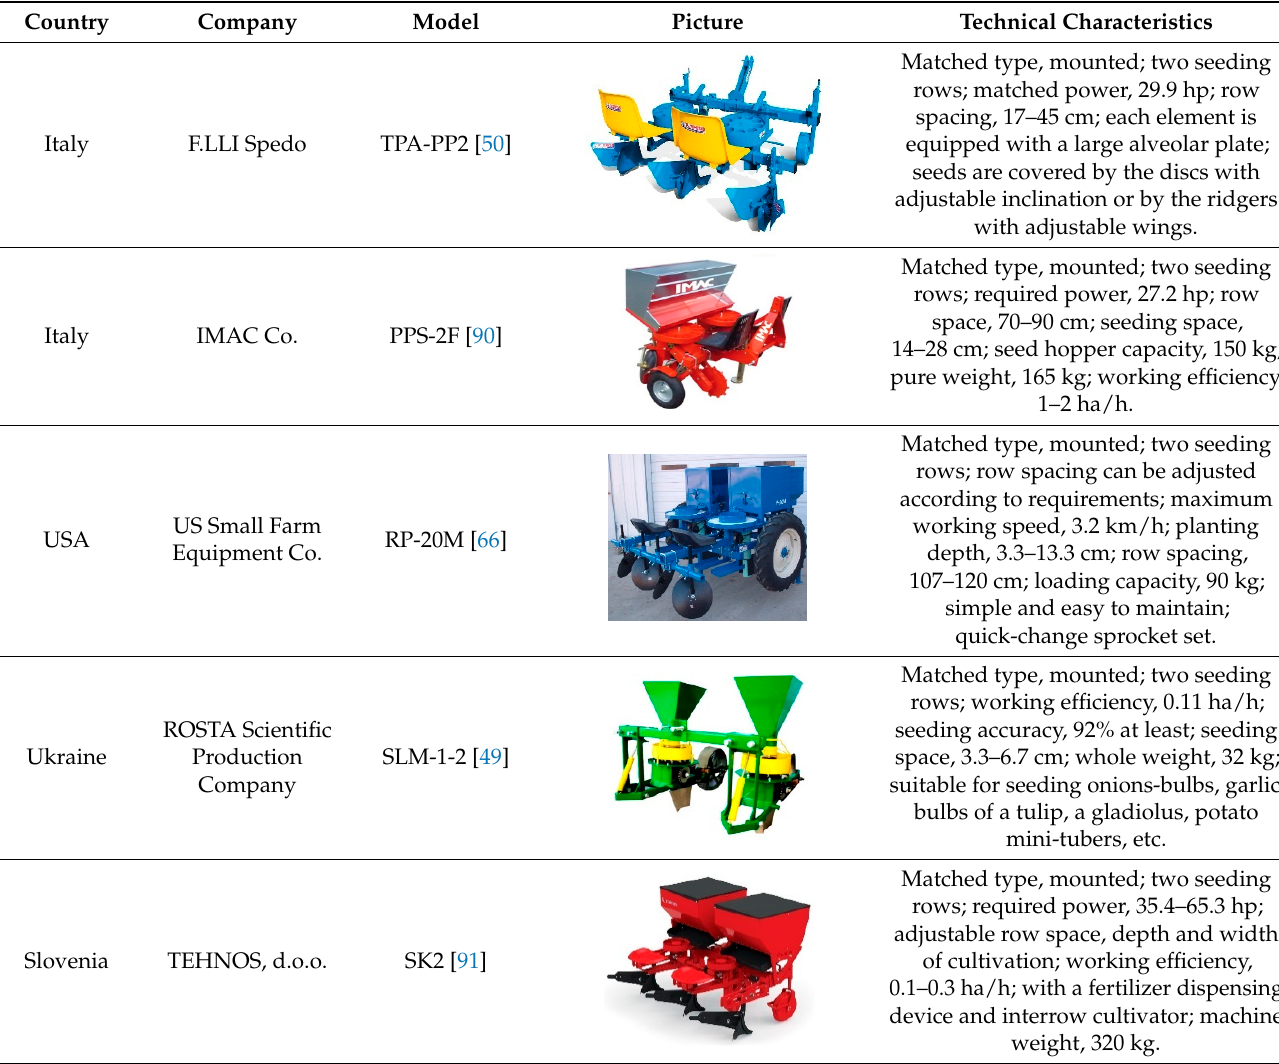
Table 6. Comparison of rotating-disc-type potato planters.